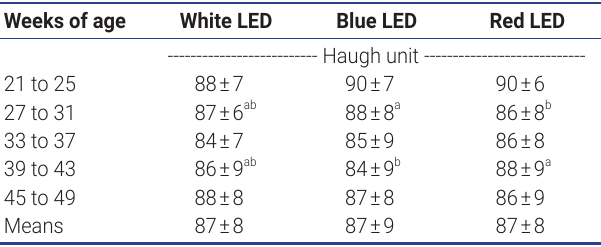
Weeks of age White LED